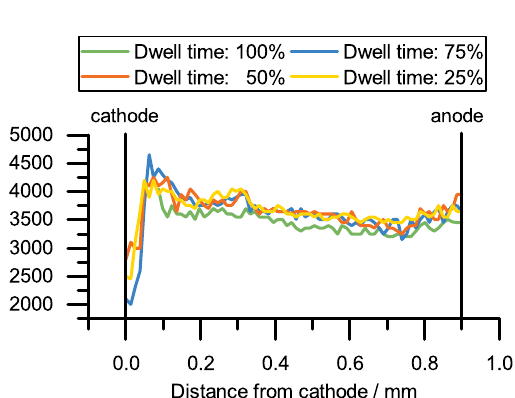
Fig. 8 Vibrational temperature during the arc phase in dependence from the distance to the